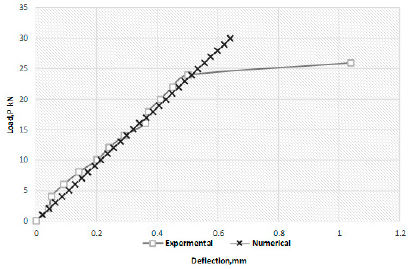
Figure 28. Load–deflection diagram of beam (B6).